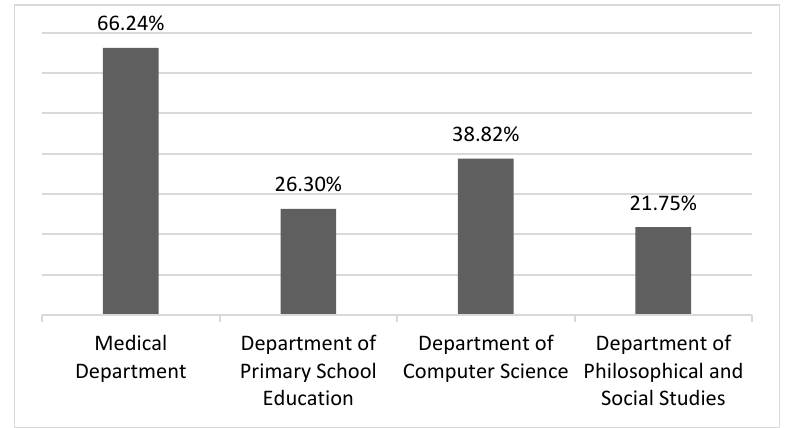
Figure 1. Percentage of students with a father who is a higher education graduate or has postgraduate studies by university department (University of Crete).